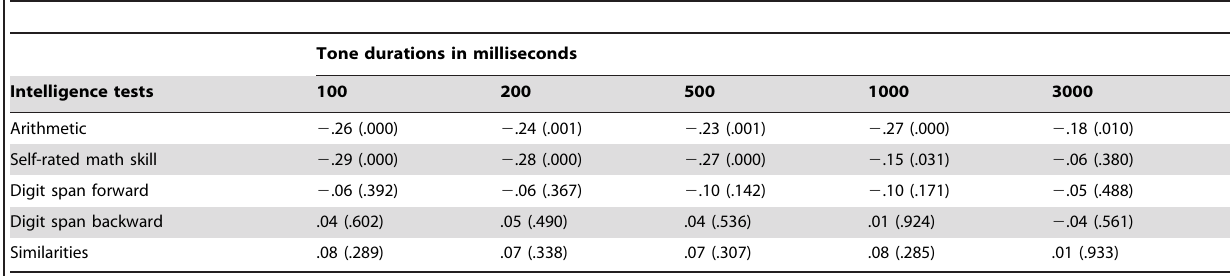
Table 3. Partial correlations between intelligence and time-estimation error for five different tone